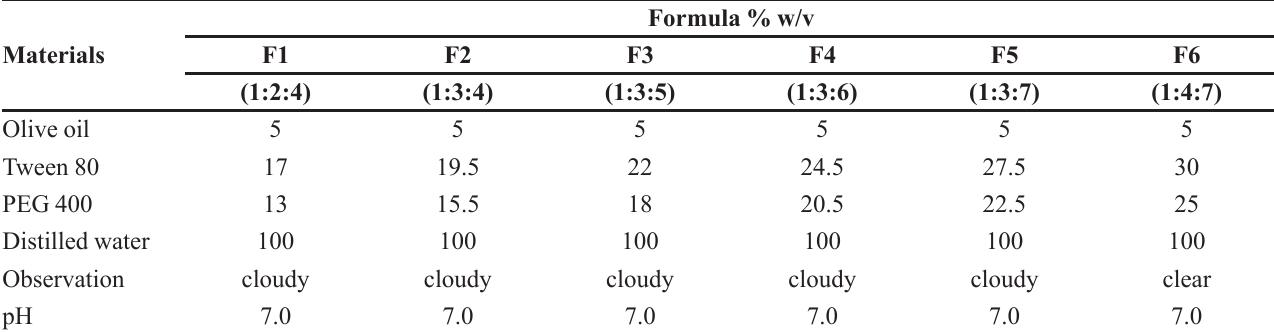
TABLE II - The optimization result of nanoemulsion basis